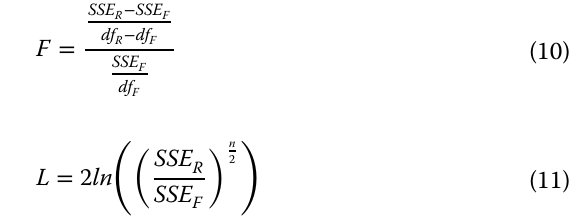
The equality of full model and reduced model was tested by considering the null hypothesis that all asso- ciated parameters were equal and equal to zero (Huang et al.